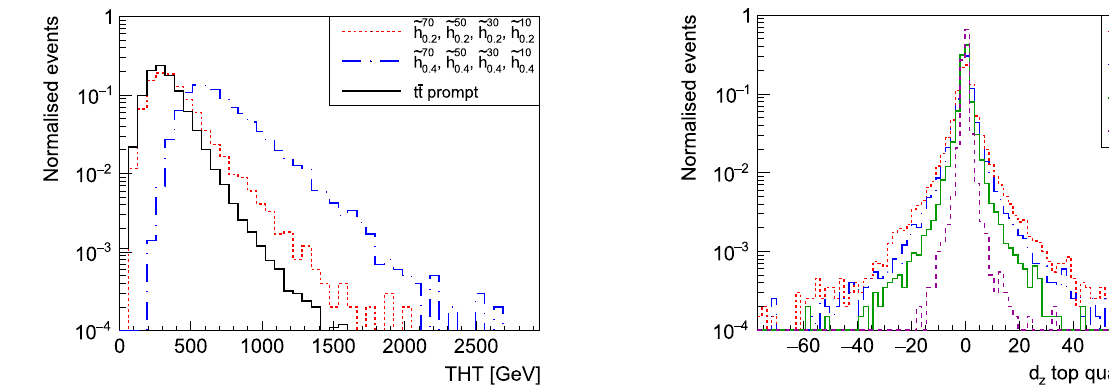
Fig. 27 Total transverse hadronic energy T HT in the ˜ h 2 -like case